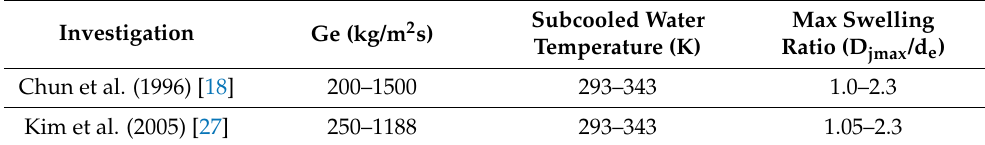
Figure 5. Maximum swelling ratio compared with subcooled water temperature. Table 3. Maximum swelling ratio.